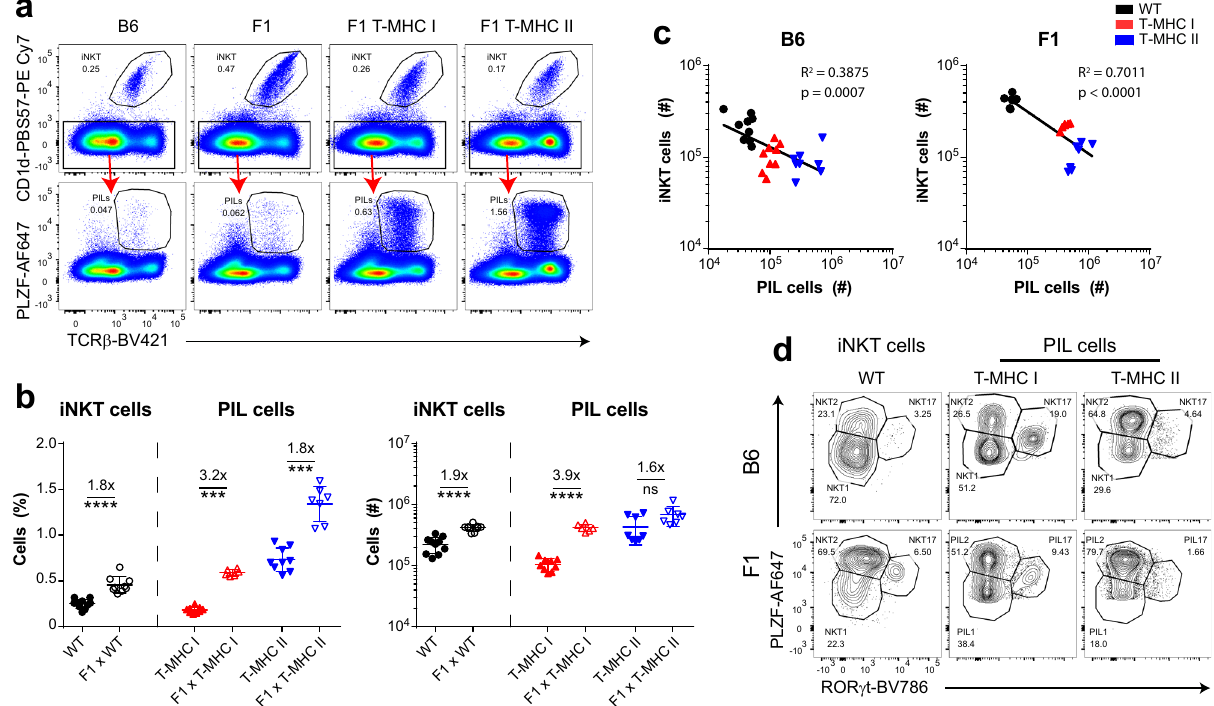
Fig. 6 PIL T cells compete with iNKT cells. a B6 WT, T-MHC I, and T-MHC II mice were crossed to BALB/c mice and F1 generation littermates (labeled as F1, F1 T-MHC I, and F1 T-MHC II) were analyzed by fl ow cytometry for frequency of iNKT and PIL T cells in the thymus. b Summary evaluation of iNKT and PIL T-cell frequency (left panel) and number (right panel) from WT, T-MHC I, and T-MHC II mice on B6 and F1 background. c Inverse correlation between number of iNKT cells and the number of PIL T cells in the thymus from WT (black dots), T-MHC I (red triangles), and T-MHC II mice (blue inverse triangles) on B6 (left panel) and F1 (right panel) background. d Shown are representative fl ow cytometry plots comparing iNKT and PIL T-cell subsets from WT, T-MHC I, and T-MHC II mice on B6 (upper row) and F1 (lower row) background. Each point represents one animal: n = 10 animals per group (WT and T-MHC I groups), n = 8 animals (T-MHC II group), n = 9 animals (F1 WT group), n = 6 animals (F1 T-MHC I group), and n = 7 animals (F1 T-MHC II group) in a – d . Data are representative of seven independent experiments. Unpaired two-tailed Mann – Whitney test was performed in b ; ns, not signi fi